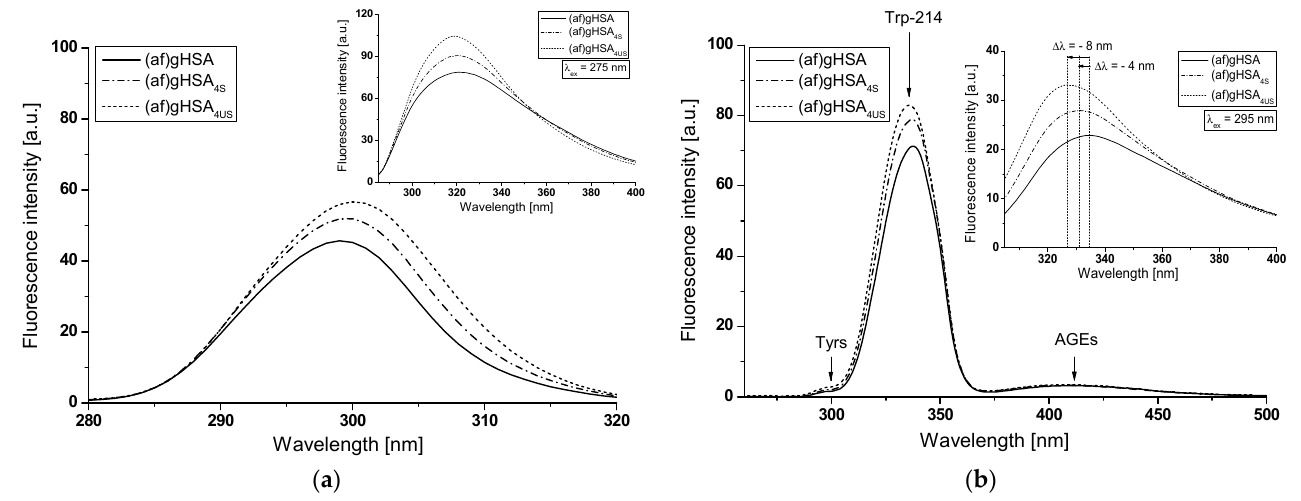
275 nm and ( b ) λ ex = 295 nm; t = 37 °C.